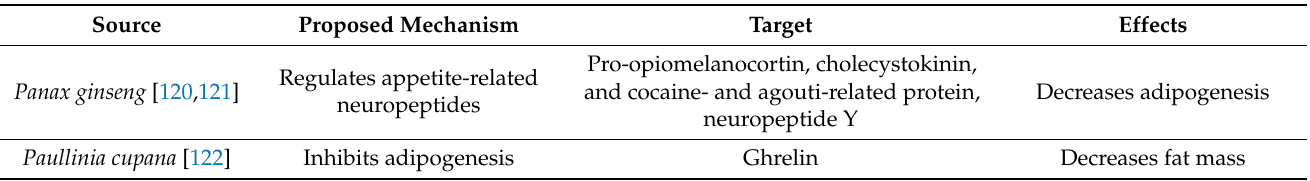
Table 11. Herbal extracts with